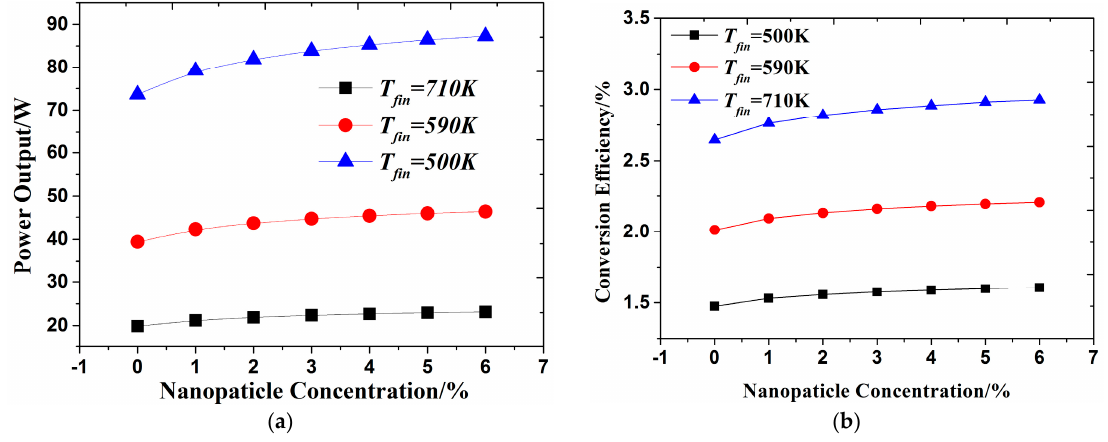
Figure 5. Variations of power output and conversion efficiency with Cu-EG nanofluid concentration under different exhaust inlet temperatures: ( a ) Power output; ( b ) Conversion efficiency.